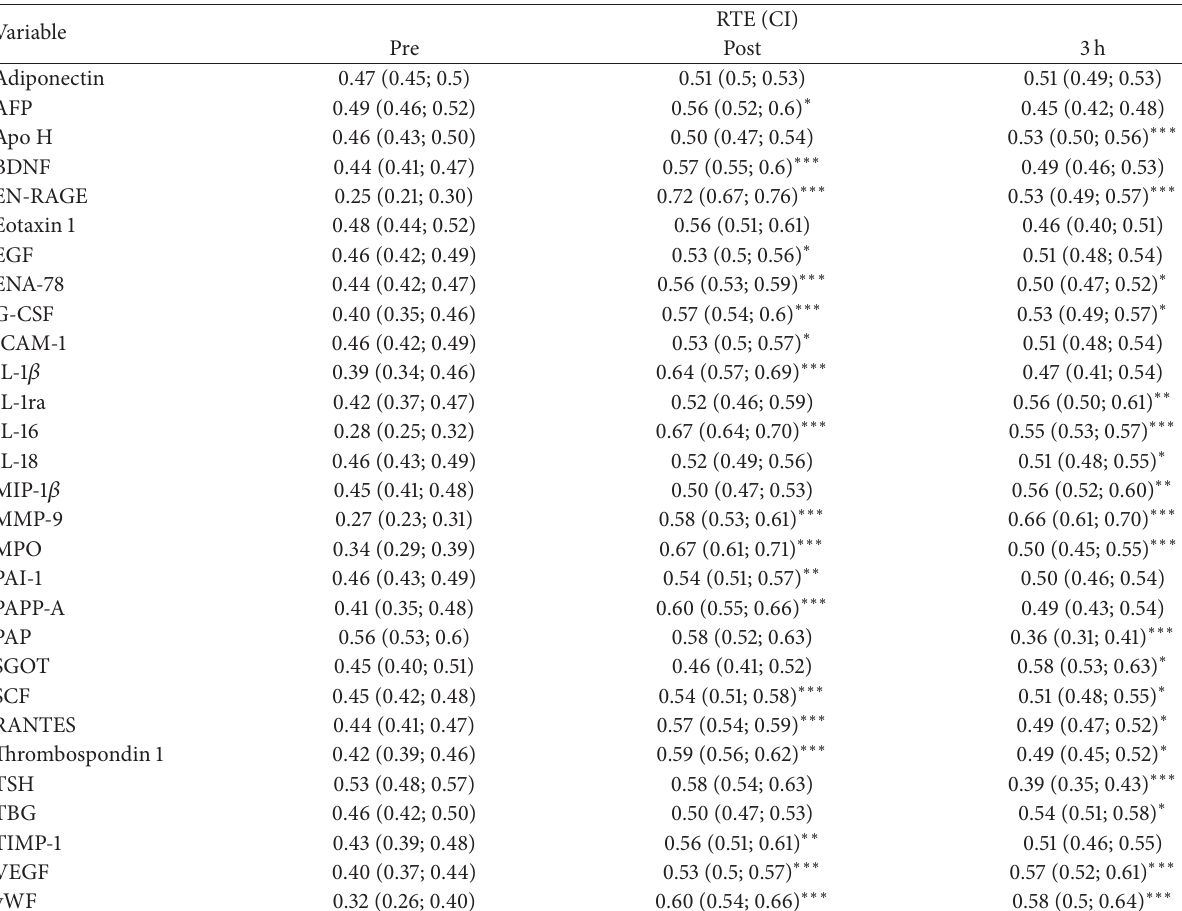
Table3:Plasmavariableswithsignificantmaineffectsoftime(a),group(b),groupandtime(c),andinteraction(groupbytime)(d).Displayed are the relative treatment effects (RTEs) and their corresponding 95% confidence intervals (CI) in parentheses. ∗ 𝑝 < 0.05 , ∗∗ 𝑝 < 0.01 , and ∗∗∗ 𝑝 < 0.001 indicate significant differences from baseline within each group based on the LD-F1 model; $ 𝑝 < 0.05 , $$ 𝑝 < 0.01 , and $$$ 𝑝 < 0.001 indicate significant differences for the main effect of group and for differences between groups for separate points of time in (d); § 𝑝 < 0.05 and §§ 𝑝 < 0.01 indicate significant interaction effects between group and time. EET: endurance-exercise-trained; SED: untrained/sedentary.